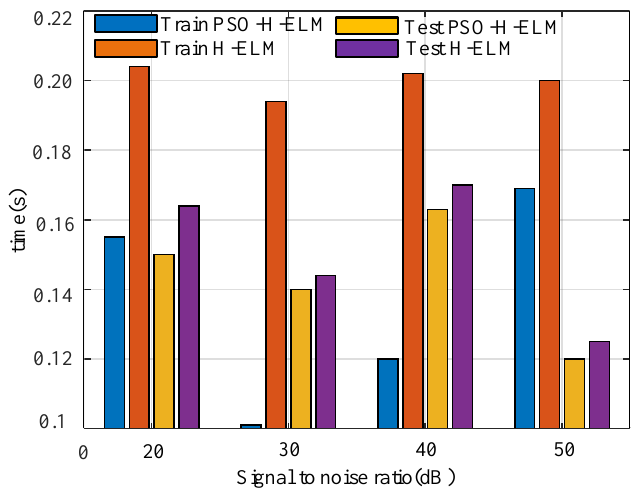
Figure 5. Test and training time histogram.